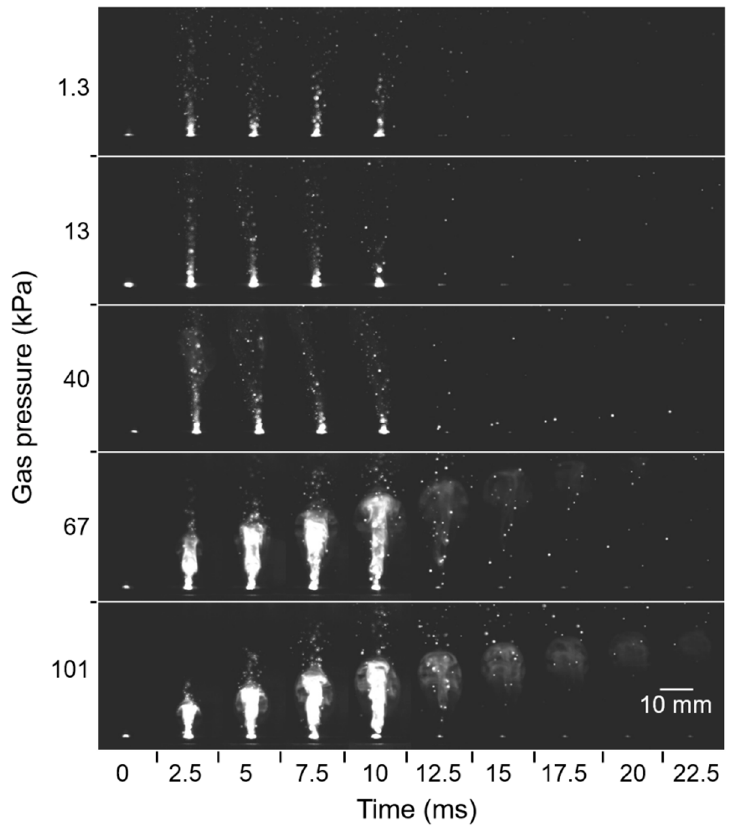
Figure 12. High-speed camera images of plume propagation at various gas pressures.